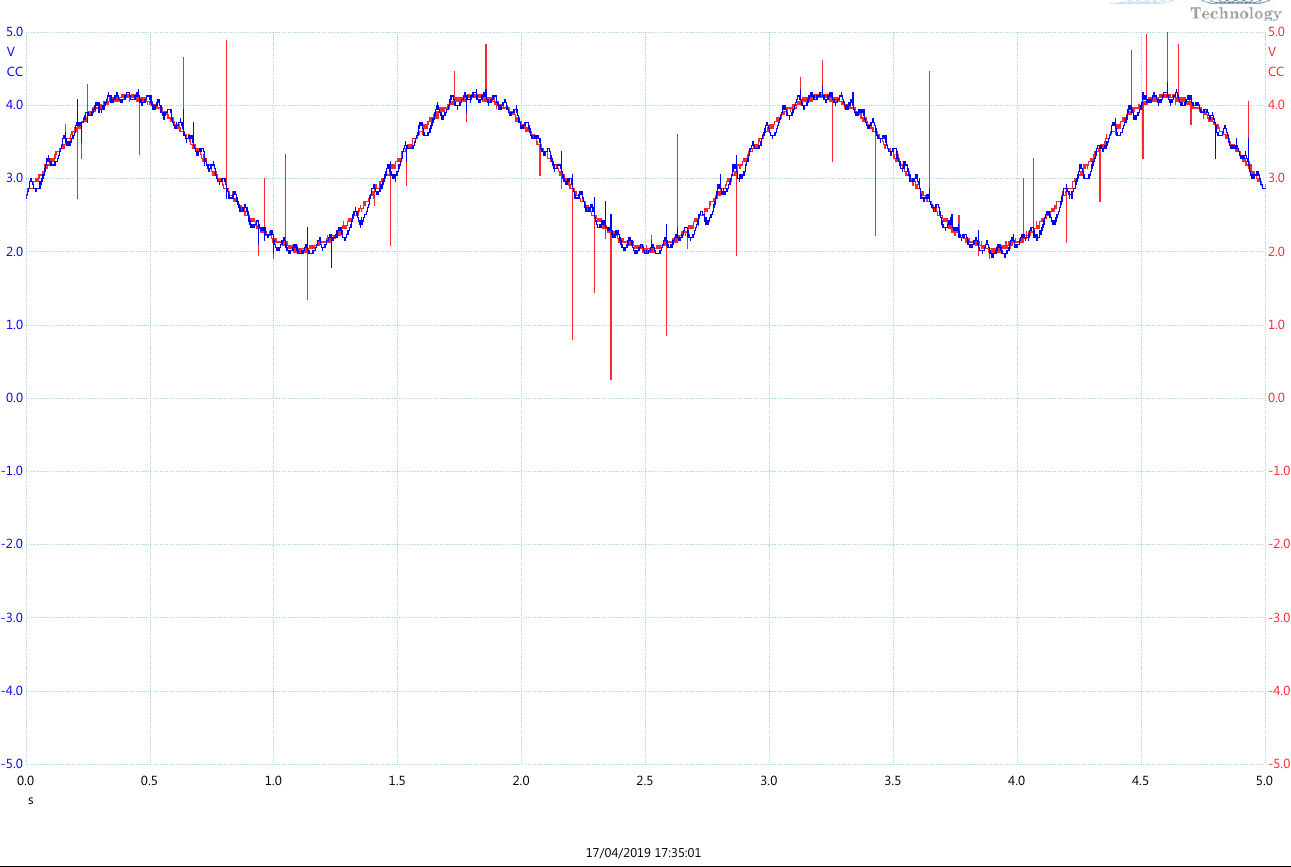
Figure 7. Experimental outcomes. The blue line is the measured throttle angular position and the red line is the programmed reference trajectory. This kind of desired tracking signal measures the ability of the controller to follow a sinusoidal reference typically employed in some mechanical harmonic